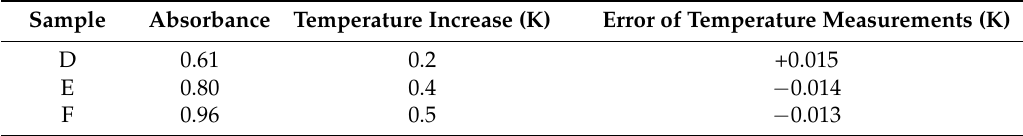
Table 2. Results from optical and thermal experiments obtained at 780 nm wavelength [35].